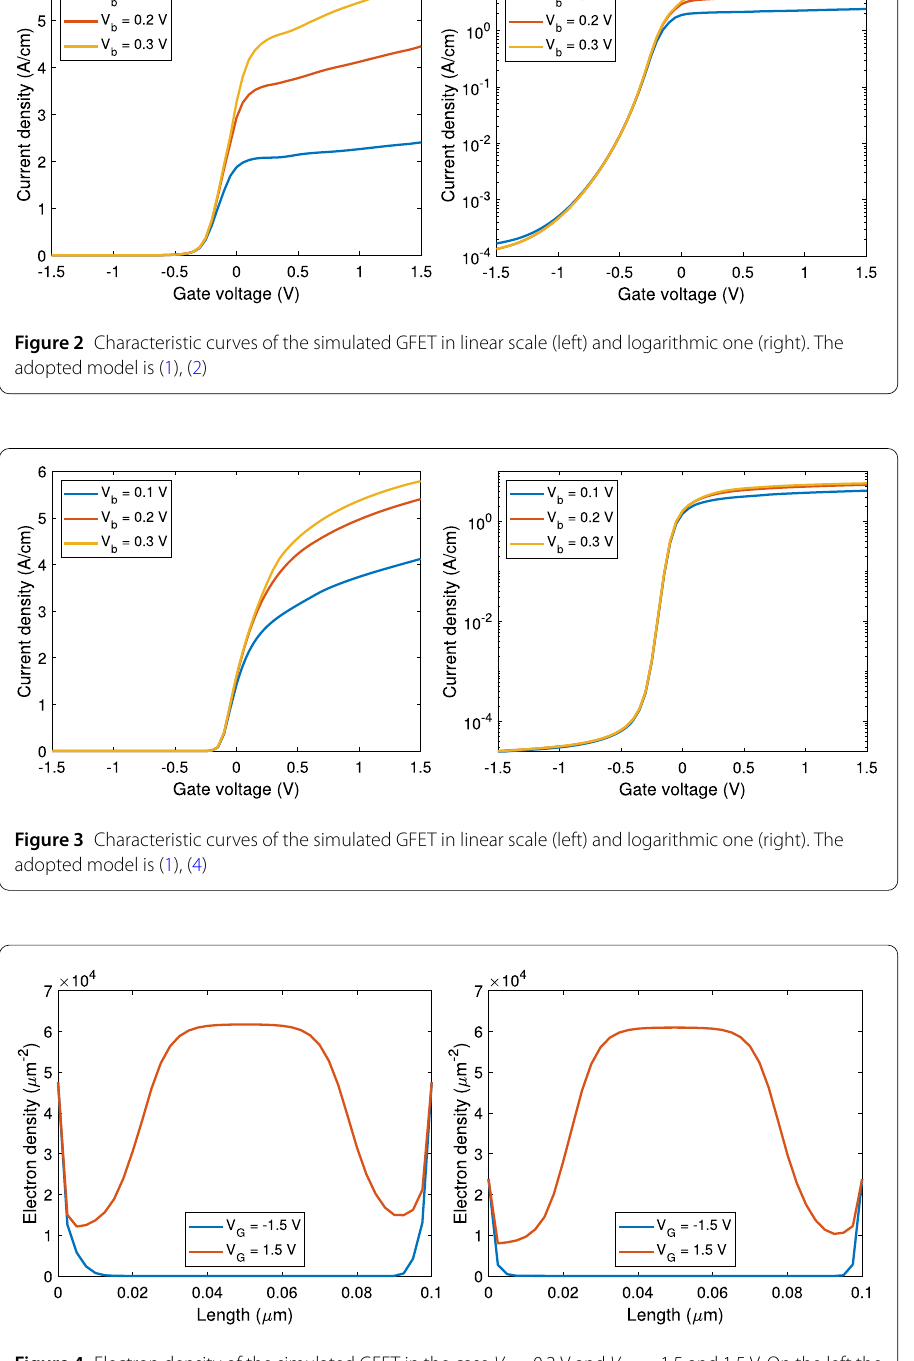
Figure 4 Electron density of the simulated GFET in the case V b = 0.2 V and V G = –1.5 and 1.5 V. On the left the adopted model is (1), (2); on the right it is (1),